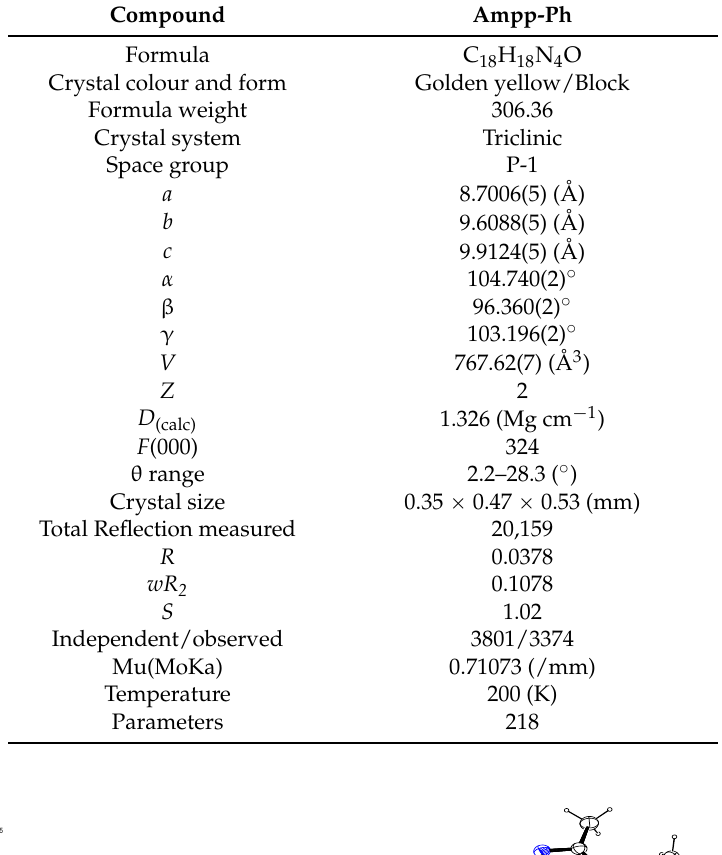
Table 1. Crystal data for Ampp-Ph.